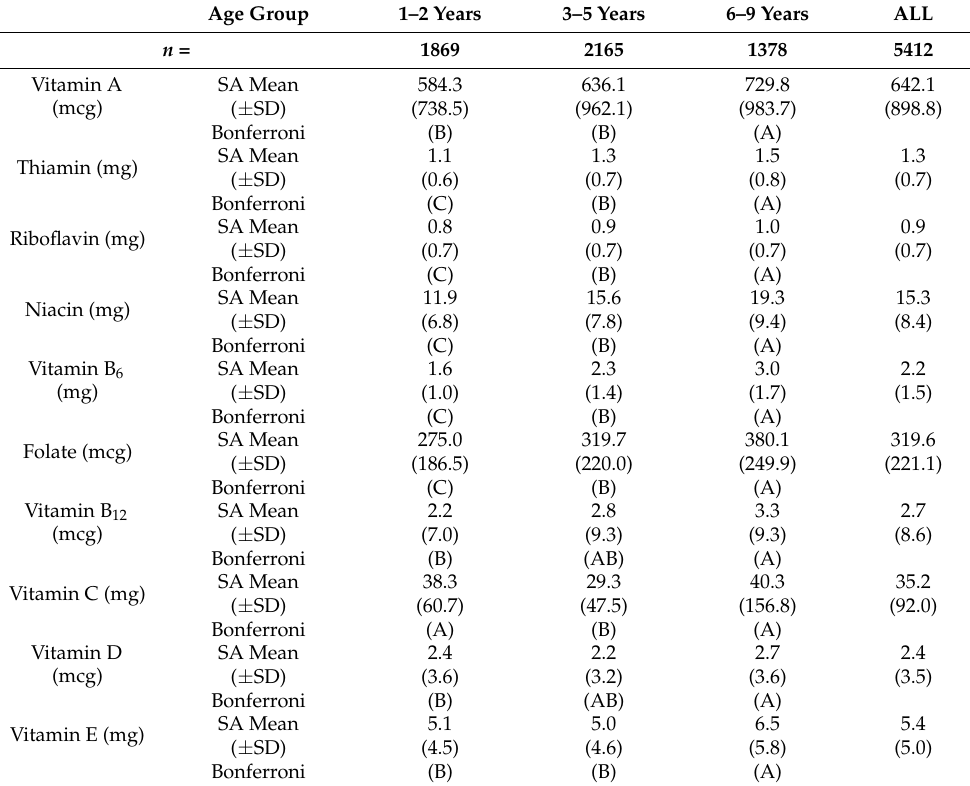
Table A3. South African child mean ± SD intake of vitamins by PDIS age